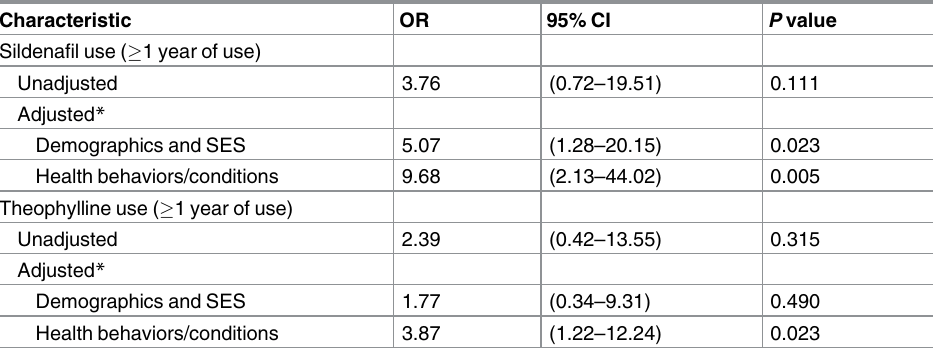
Table 3. Logistic regression models for the association between self-reported glaucoma and use of sildenafil and theophylline, in the National Health and Nutrition Examination Survey (NHANES)2005–